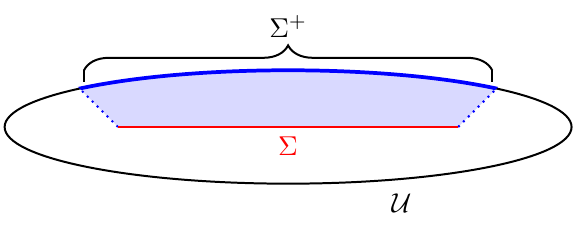
Figure 2 . The support of (cid:14)(cid:30) on @ U is contained in (cid:6) + = J + ((cid:6)) \ @ U